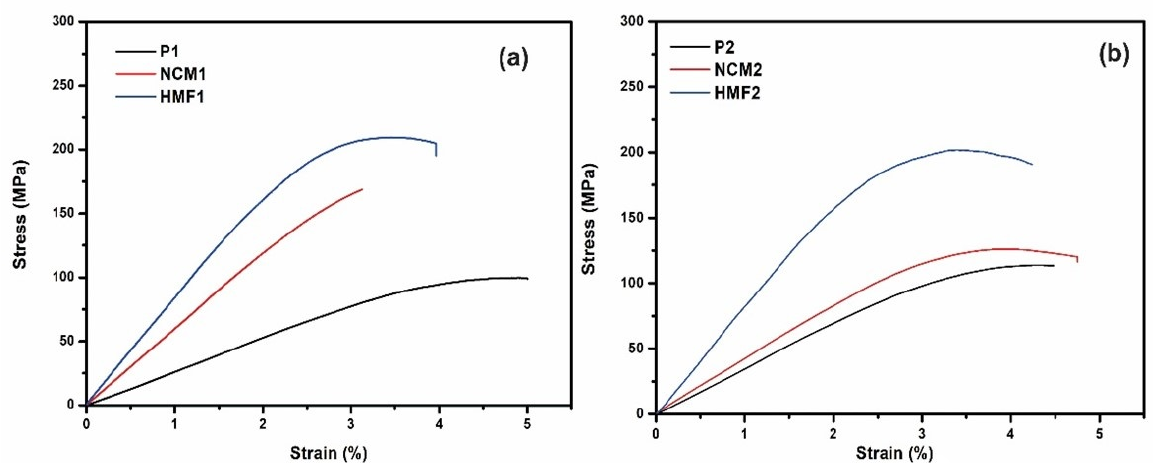
Figure 6. Graphic of the bending resistance for ( a ) test pieces made with cured resin 1 (P1), nanocom- posite made with resin 1 and ZnO-NPs without functionalization (NCM1), and hybrid material (HMF1) and ( b ) test pieces made from cured resin 2 (P2), nanocomposite made from non-functioning resin 2 and ZnO-NPs (NCM2), and hybrid material